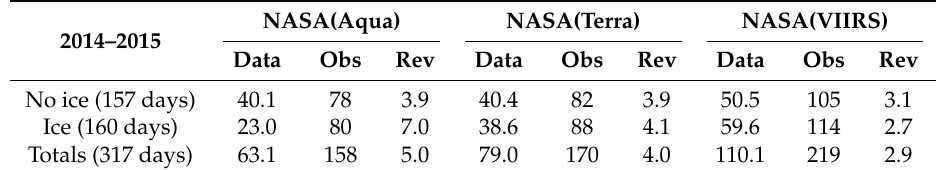
Table 2. Comparison of cloud mask statistics over river grid cells, categorized by ice cover, obtained from NASA processing. Data: see Equation (2); Obs: number of days on which at least one grid cell was observed; Rev: see Equation (1), in days. The number in brackets of the first column specifies how many days corresponded to “no ice” or “ice”, as per the discharge quality flag.